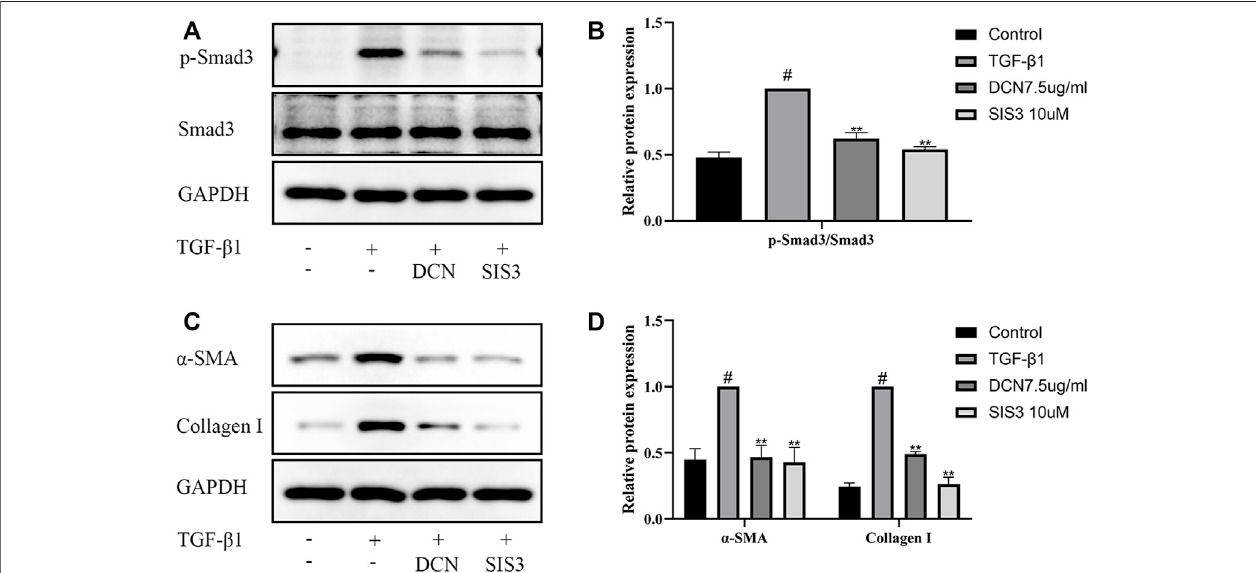
FIGURE 5 | TGF- β 1-induced Smad2/3 signaling pathway activation, fi broblast transdifferentiation, and ECM synthesis are inhibited by SIS3 (a novel speci fi c inhibitor of Smad3). (A) Western blotting and (B) quanti fi cation analysis of Smad3 and p-Smad3 from fi broblasts after treated with DCN (7.5 µg/ml) or SIS3 (10 µM) for 2 h, followed by incubation with TGF- β 1 (5 ng/ml) for 1 h. (C) Western blotting and (D) quanti fi cation analysis of α -SMA and collagen I from fi broblasts after treated with TGF- β 1(5 ng/ml) in the presence ofDCN (7.5 µg/ml) or SIS3 (10 µM) for48 h. # p < 0.05 vs control group; * p < 0.05 vs TGF- β 1 group; ** p < 0.01 vs TGF- β 1